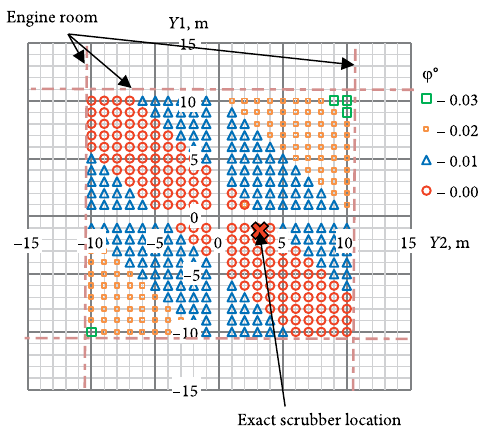
Fig. 13. The deviation of righting arm depending on the displacement of the whole scrubber system on Y and Z